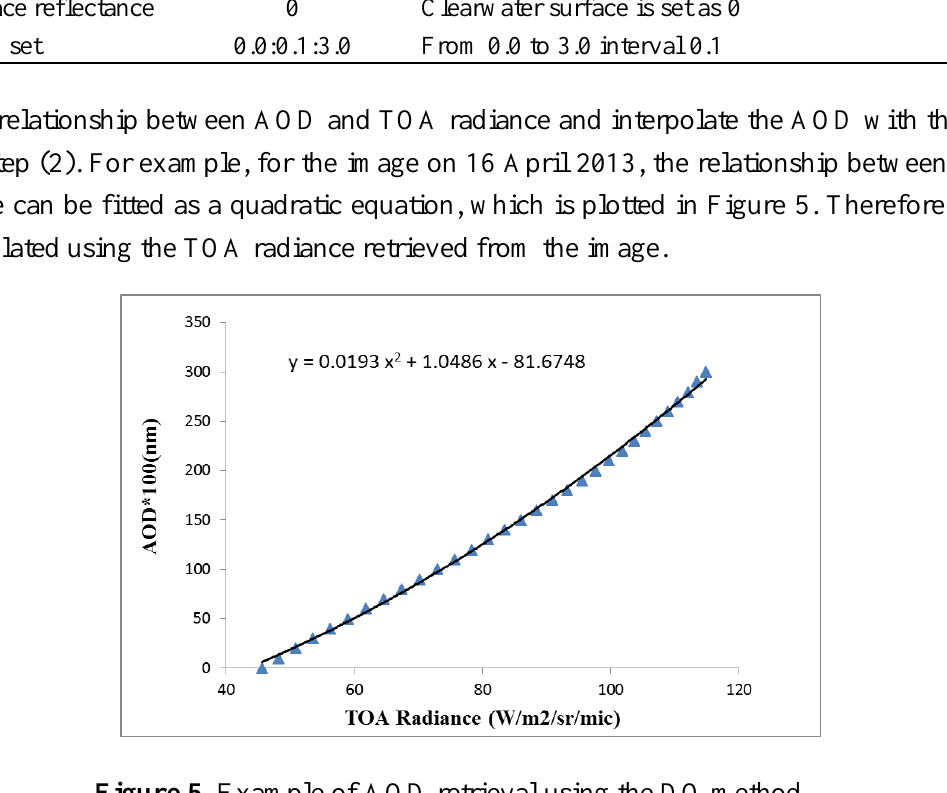
Figure 5. Example of AOD retrieval using the DO